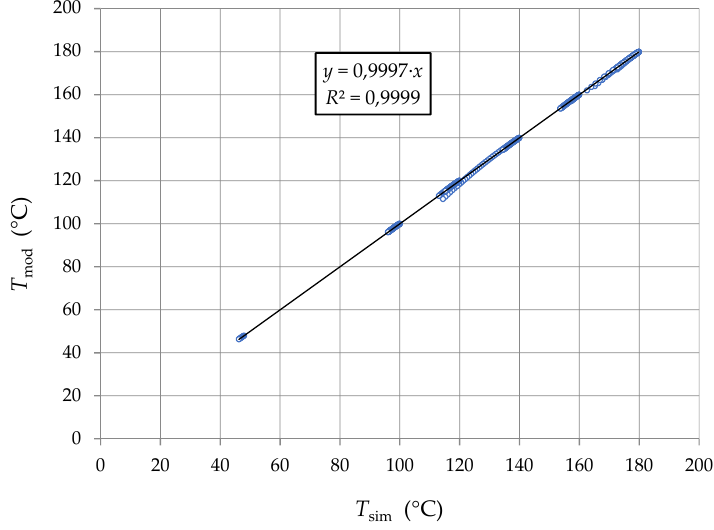
Figure 5. Correlation between the temperature of the liquid predicted by the model and the tempera-